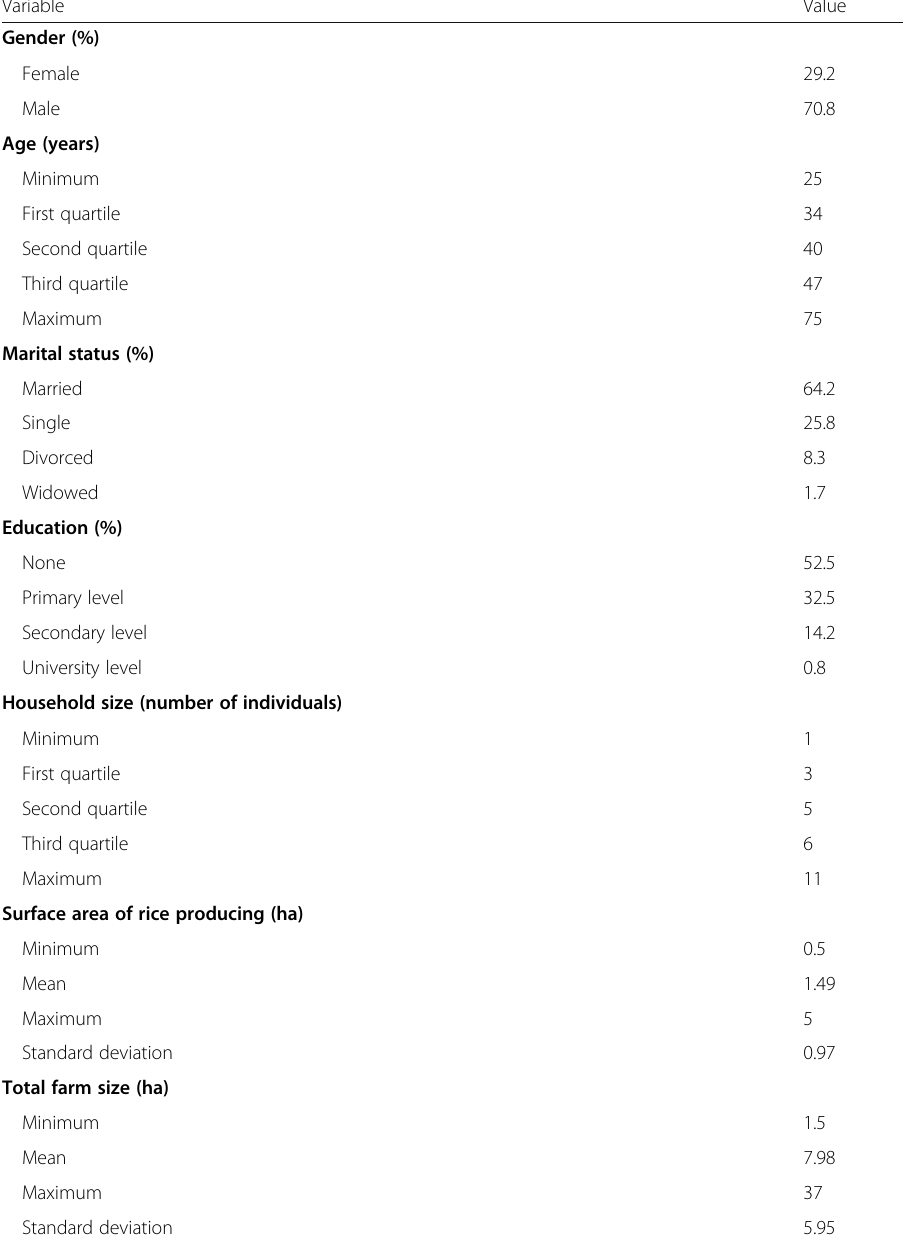
Table 1 Socio-demographic characteristics of rice